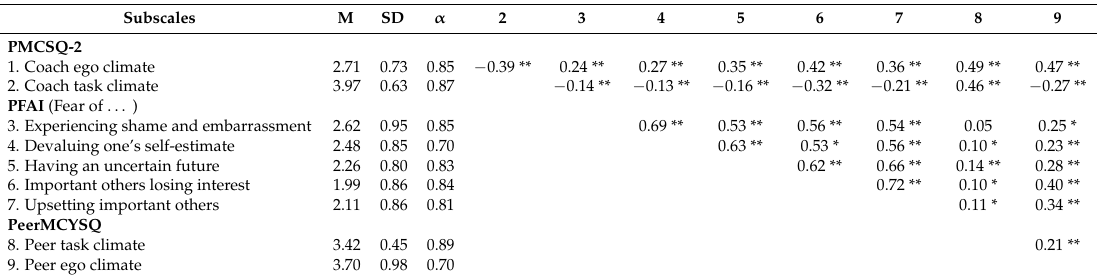
Table 1. Descriptive statistics, Cronbach’s alpha and correlations between the subscales of the